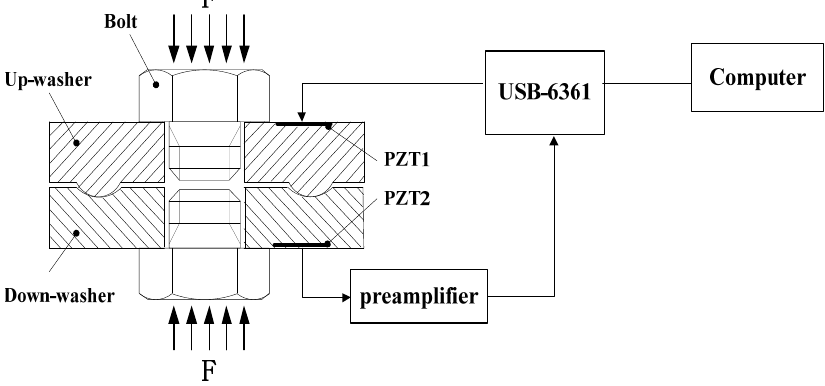
Figure 5. Experimental scheme.